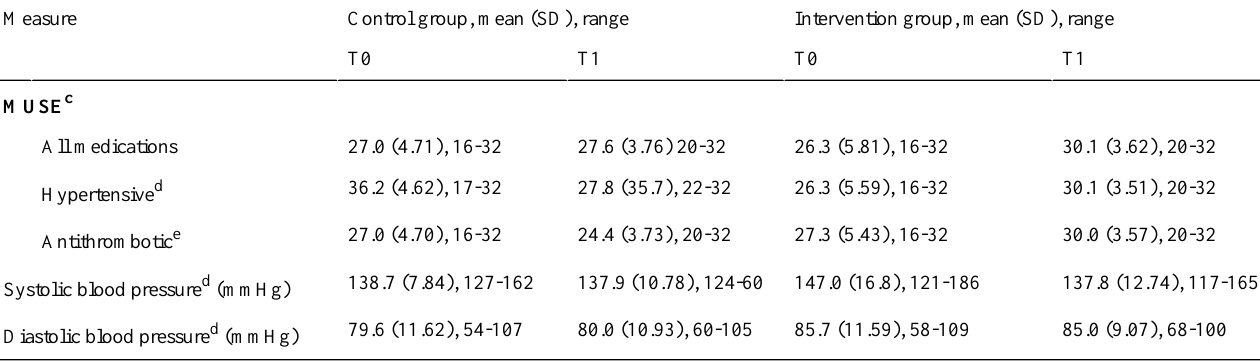
Intervention group, mean (SD), rangeControl group, mean (SD),